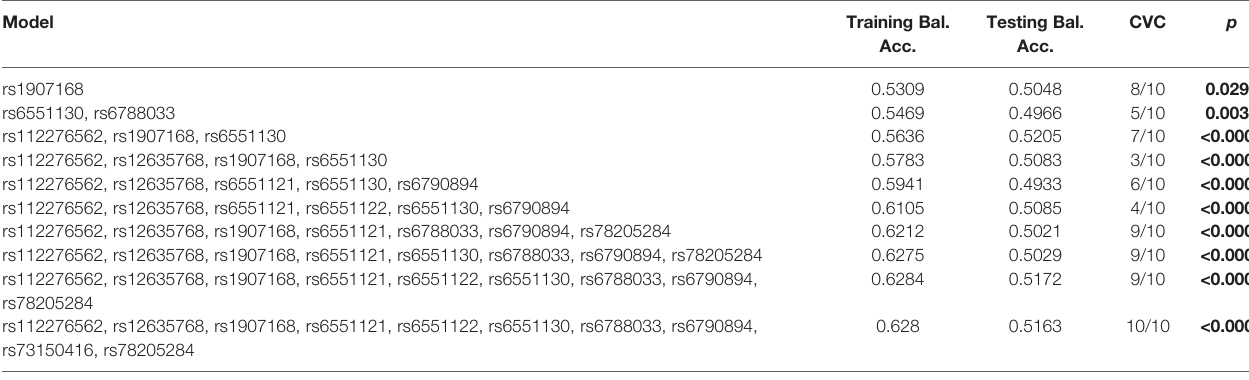
TABLE 6 | SNP – SNP interaction models of LRRC3B gene analyzed by the MDR method. Model Training Bal.